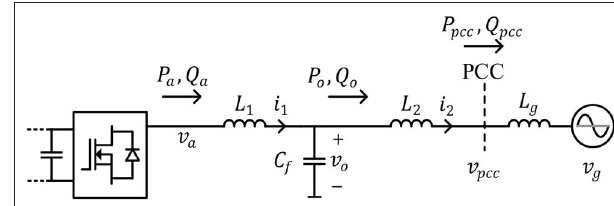
FIGURE 3 | A GFM converter connected to an electrical network modeled by an equivalent source v g and an inductance L g .